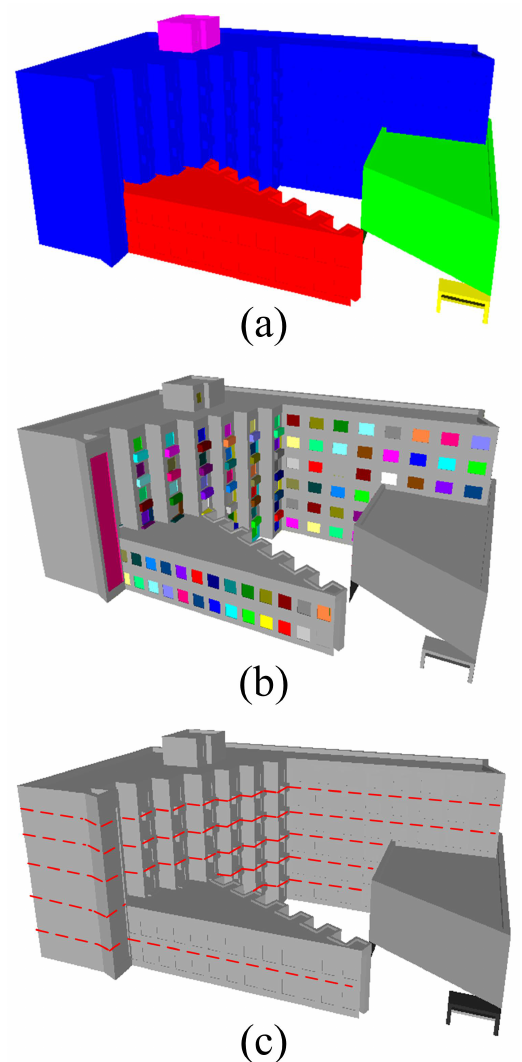
Figure 2. Storey recognition of the building model. (a) Compositional structure recognition. (b) Surface feature extraction. (c) Floor delamination on the